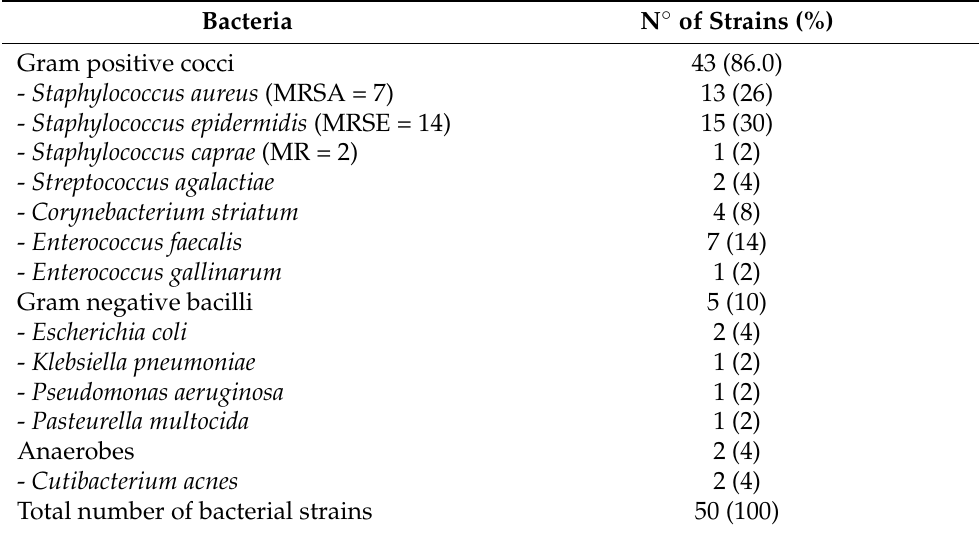
Table 2. Microbiology of 33 patients with periprosthetic joint infections.